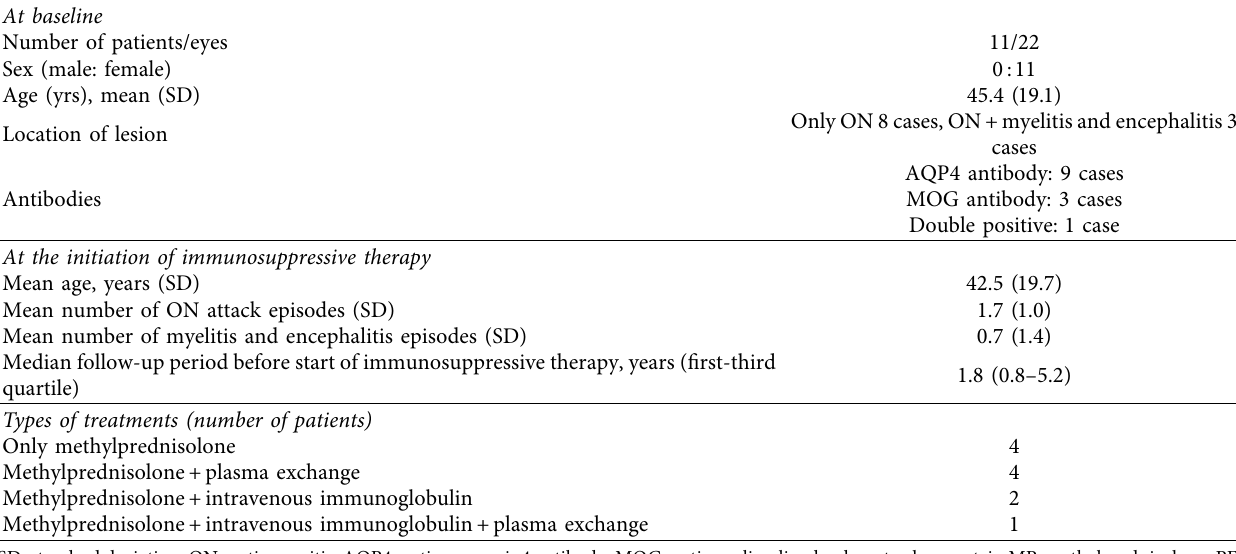
Table 1: Summary of patient characteristics.